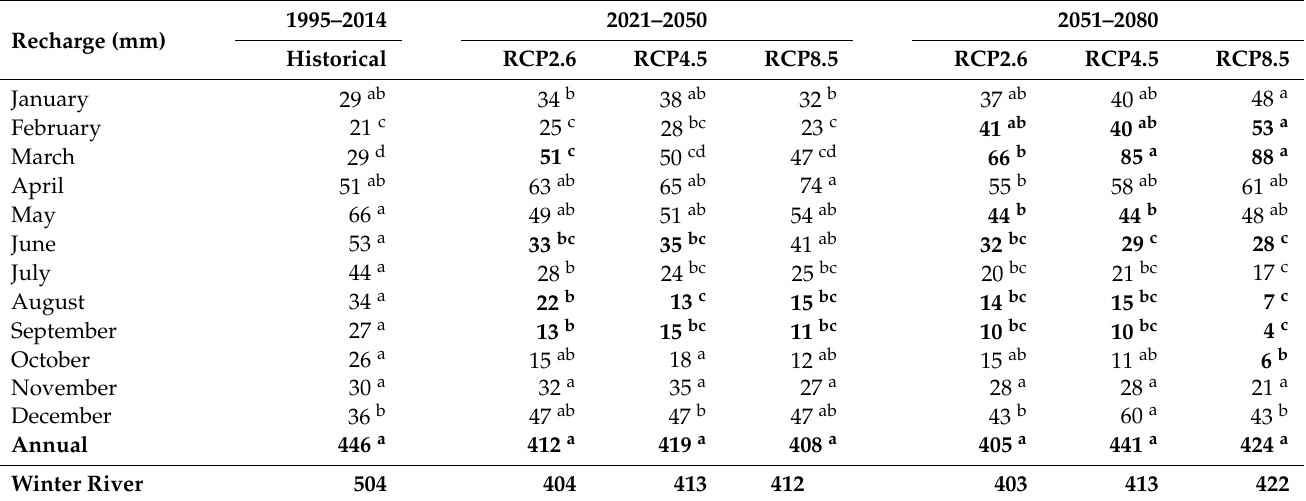
Table 11. Average recharge (mm) in the central zone (West, and Winter River watersheds)